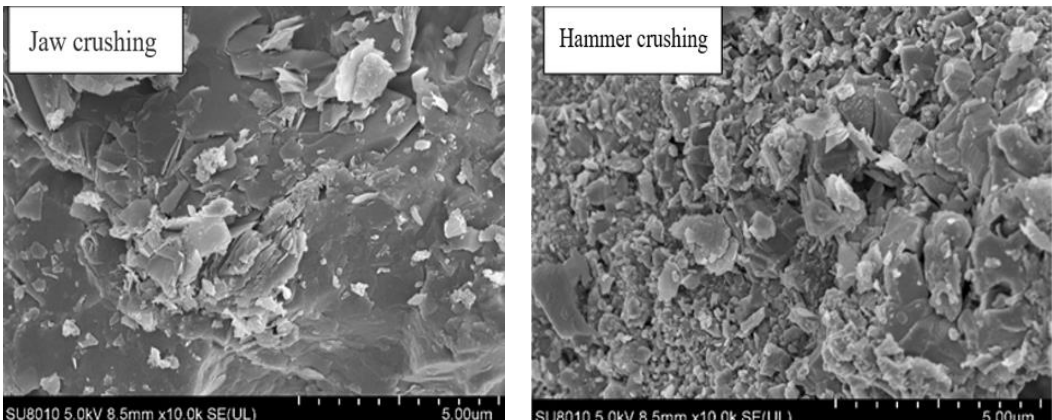
Figure 3. SEM of coal gangue under two crushing modes.